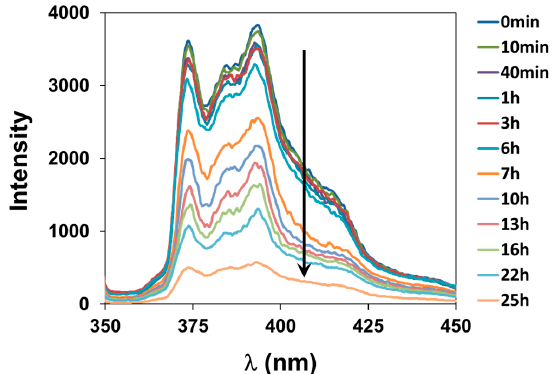
Figure 4. Time course of fluorescence spectra of pyrene entrapped in EI 4 /Gal-Dex- g -SS-OLA nanogels after addition of 10 mM DTT in PB solution at 25 °C. Black arrow means time course.